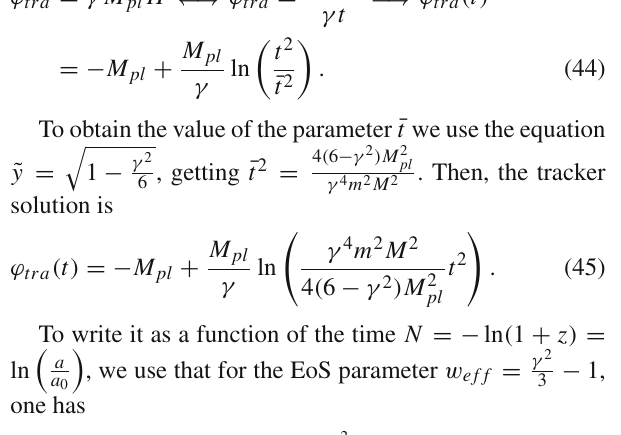
γ 2 < 6 it is a saddle point [57]. Moreover, at the fixed